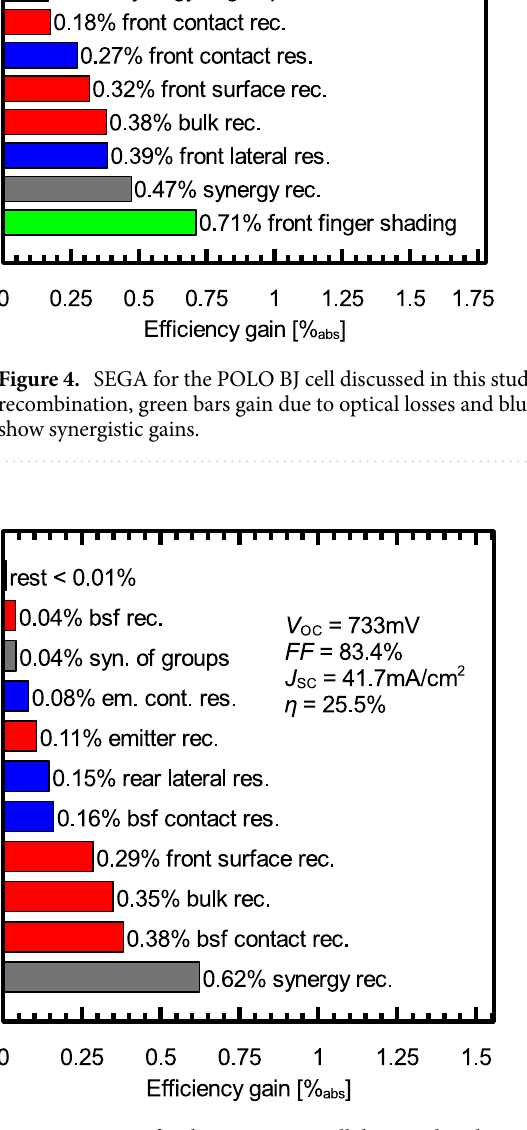
Figure 5. SEGA for the POLO IBC cell discussed in this study. Red bars show potential efficiency gains due to recombination, green bars gain due to optical losses and blue bars gain due to resistive losses. The gray bars show synergistic